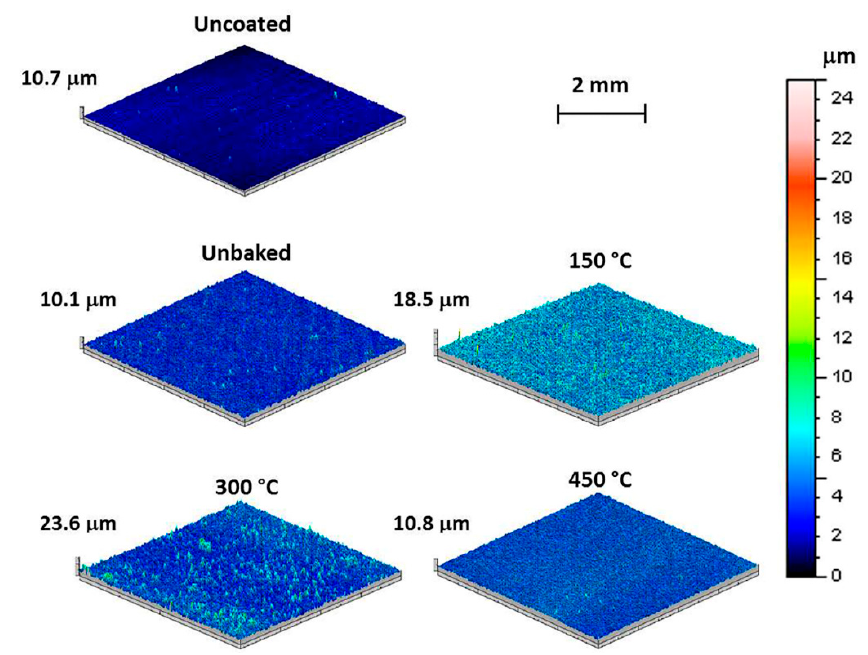
Figure 3. 3D maps of the samples uncoated, unbaked and coated and baked at 150 °C, 300 °C, and 400 °C.